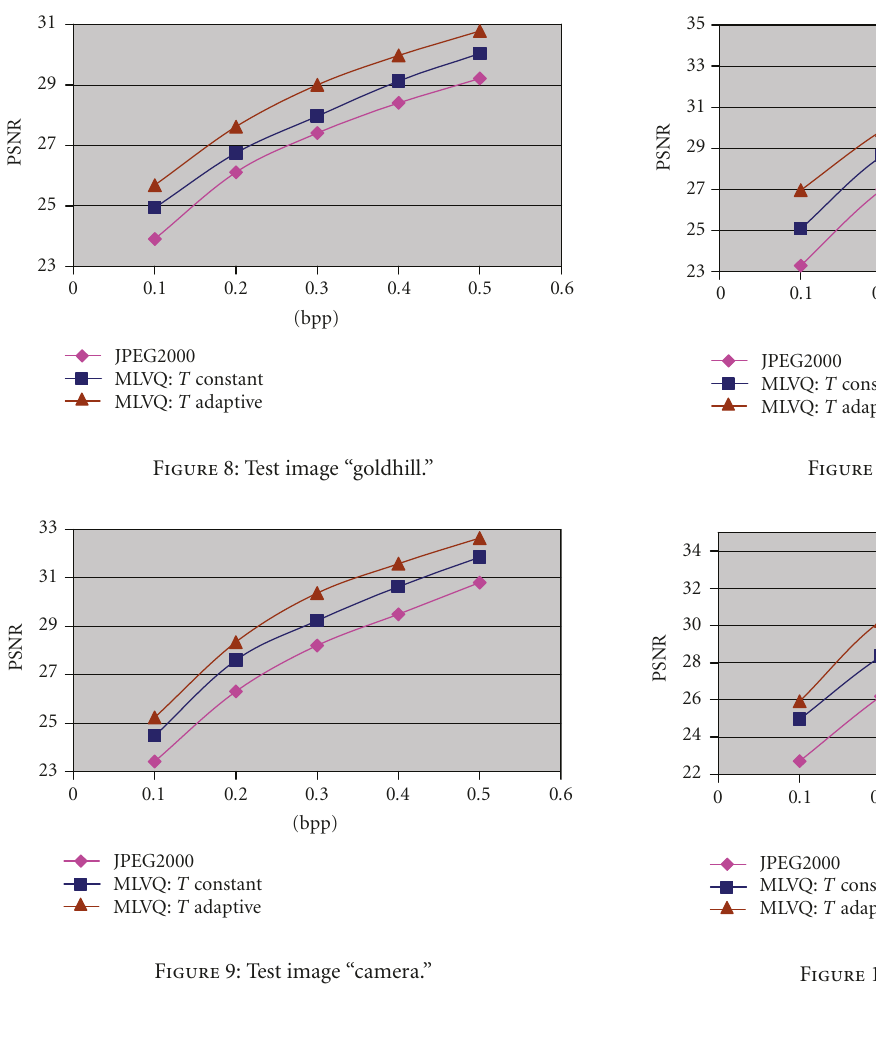
Figure 11: Test image “clown.”